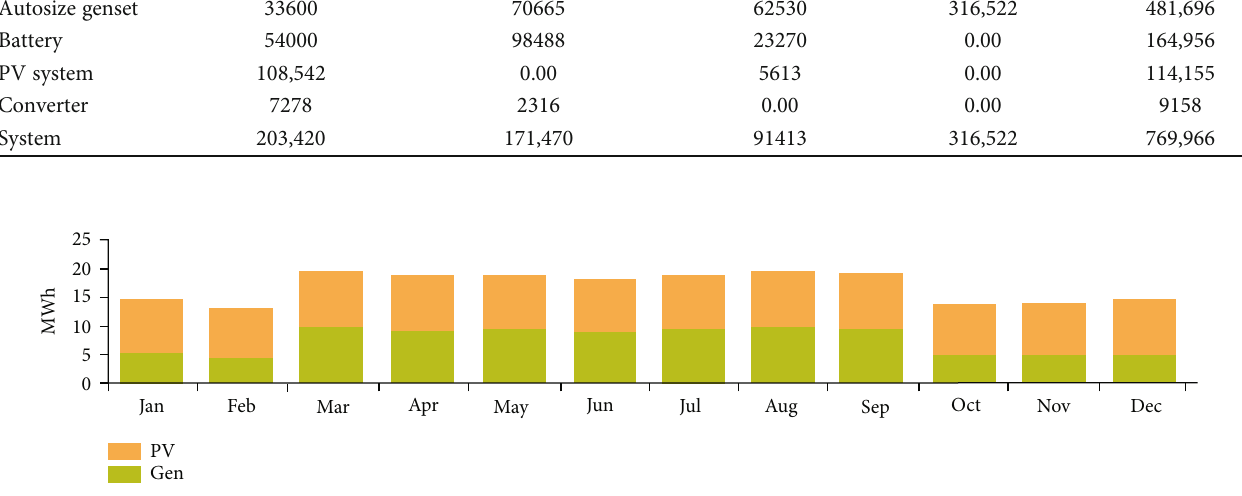
Figure 11: Monthly average electricity production of the hybrid PV/diesel system with battery for the tertiary